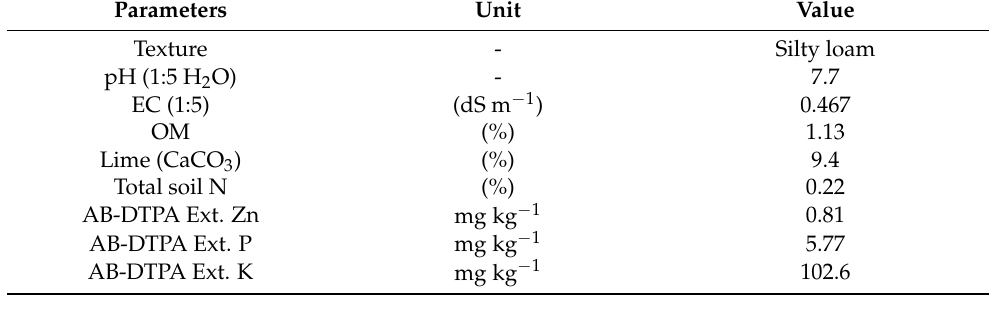
Table 1. Pre-sowing characteristics of the soil used in the experiment.